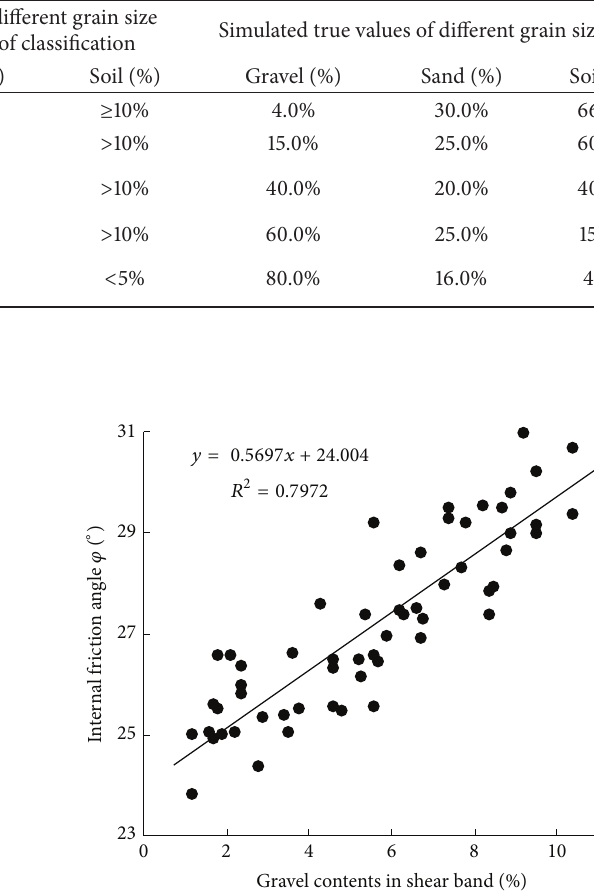
Figure 9: Relationship between gravel contents in shear bands and internal friction angle.